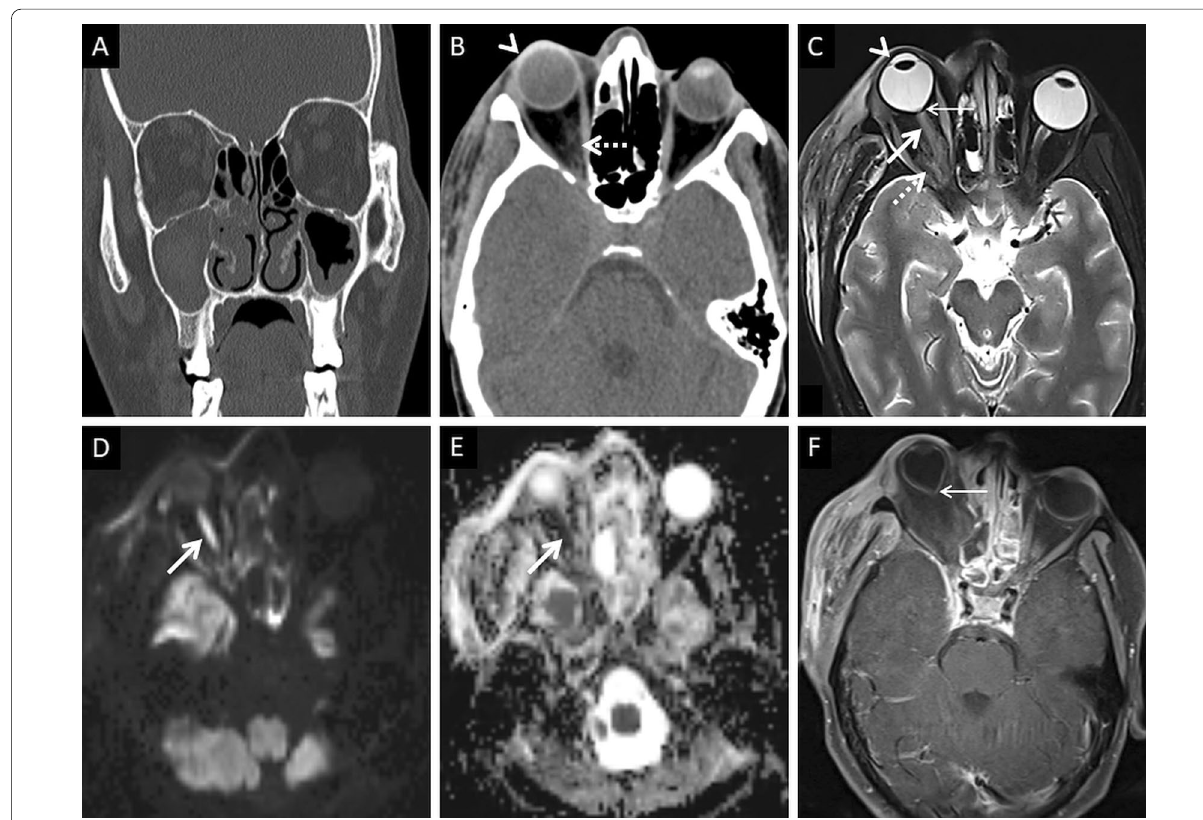
Fig. 14 ROCM-related ONI and endophthalmitis. Coronal CT image of the paranasal sinuses ( a ), obtained using the bone algorithm, reveals opacification of the maxillary sinuses, worse on the right. Axial CT image ( b ), using the soft tissue algorithm, demonstrates subtle right orbital fat stranding (dotted arrow) and mild right proptosis (arrow head). Axial T2-FS image ( c ) confirms the right orbital stranding (dotted arrow) and right proptosis (arrow head). Note the subtle tenting of the posterior aspect of the right globe (thin arrow) and thickening of the right optic nerve (thick arrow). Axial diffusion weighted ( d ) and apparent diffusion coefficient ( e ) images reveal restricted diffusion within the right optic nerve in keeping with an optic nerve infarction. Overall, findings of orbital compartment syndrome with endophthalmitis and optic nerve infarction was suggested. The patient underwent urgent surgery, with removal of the right lamina papyracae, for relief of the compartment syndrome. CE FS axial T1W image ( f ) reveals interim worsening of the right endophthalmitis (thin